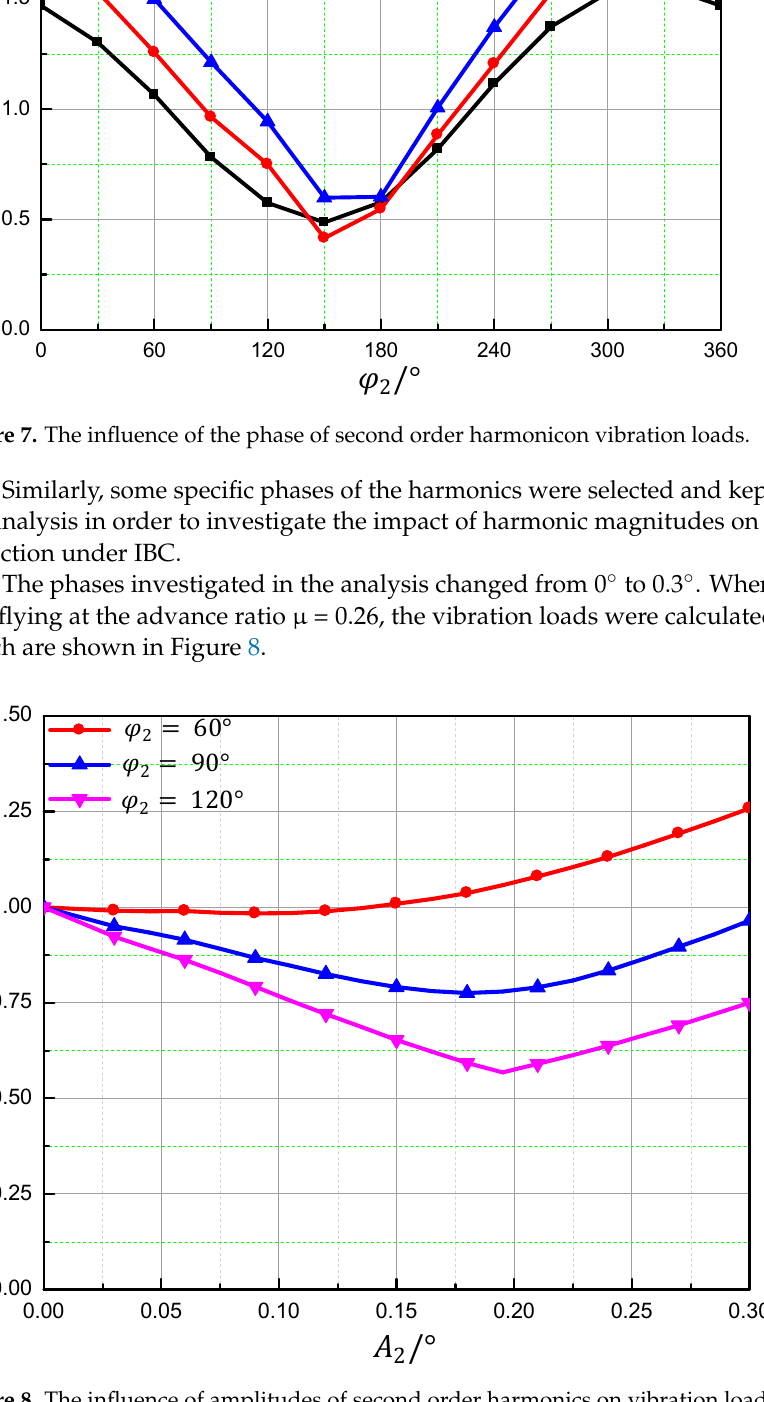
Figure 8. The influence of amplitudes of second order harmonics on vibration loads.